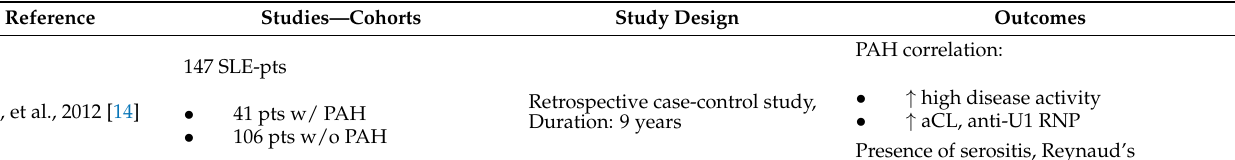
Table 1. Published studies investigating the role of biomarkers in SLE patients with pulmonary